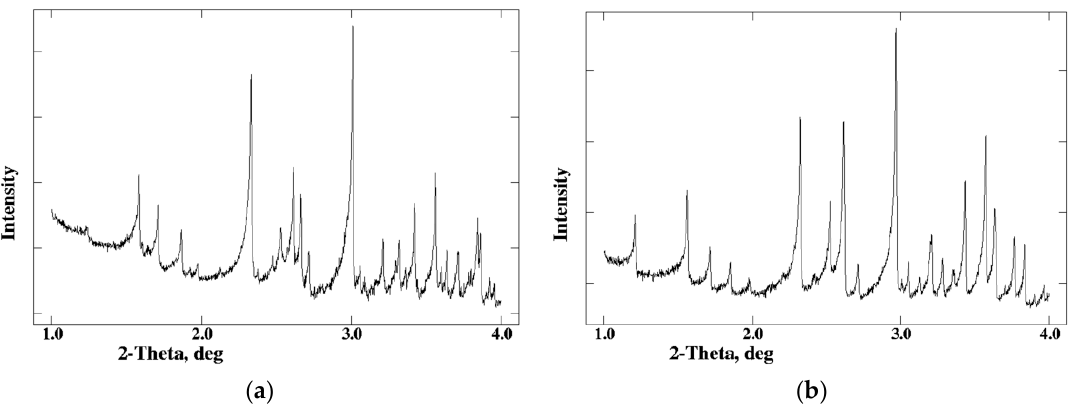
Figure 1. X ‐ ray powder diffraction (XRPD) patterns of Zn ‐ human insulin collected with λ = 0.700233 Å. ( a ) XRPD pattern of freshly ground Zn ‐ human insulin complex (T 3 R 3 DC); ( b ) XRPD pattern of aged ( a ) XRPD pattern of freshly ground Zn-human insulin complex (T 3 R 3 DC); ( b ) XRPD pattern of aged Zn-human insulin complex (T 3 R 3f ); the pattern shown was produced by the sum of two individual scans collected at 2 s · step − 1 and 0.002 ◦ step − 1 (Reproduction of Figure 1 from reference